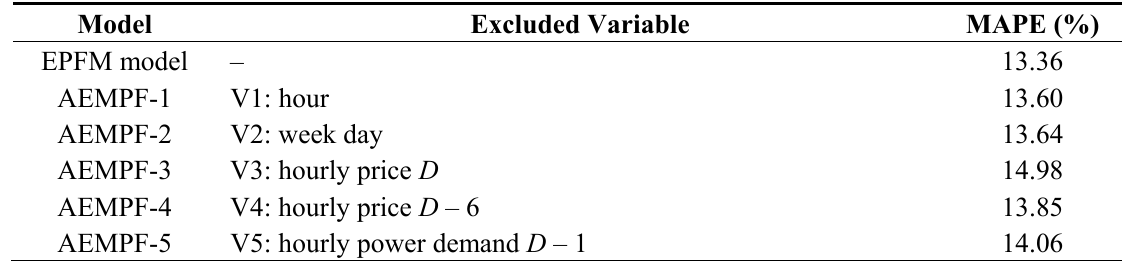
Table 4. Alternative Explanatory models for Price Forecasts and their MAPE